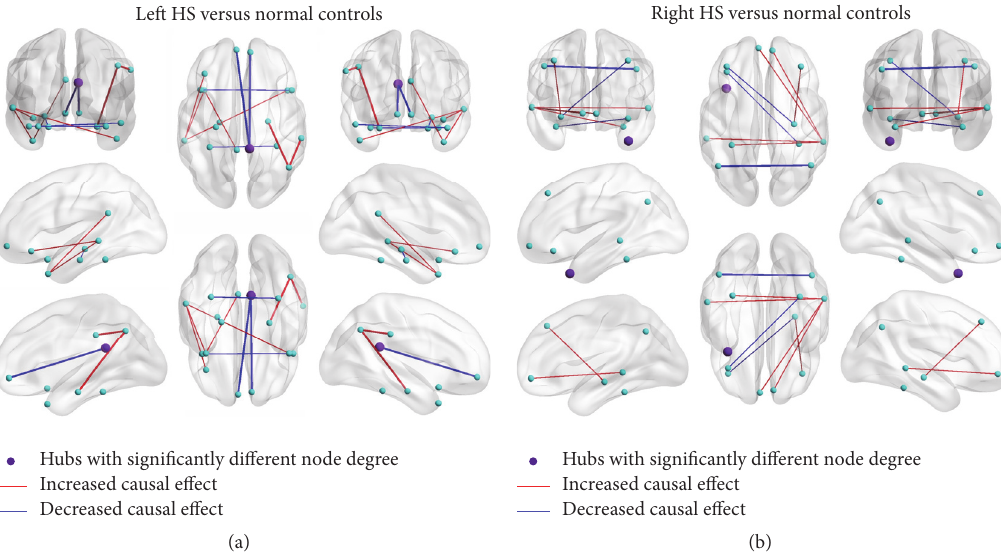
Figure 4: Changes of the driving effect between nodes in the semantic cognition network between the left HS, right HS, and normal controls. (i) The driving effect between nodes in ipsilateral structures increased and it decreased between nodes of contralateral structures in patients with left HS. (ii) Directional interaction weight changes between normal and patients with right HS seemed rather systematic, as an increased causal connectivity change was accompanied with a decreased intensity change and vice versa. (iii) The node degree of the right PCC was significantly different between patients with left HS and controls, and the node degree of the right MTG was significantly different between patients with right HS and